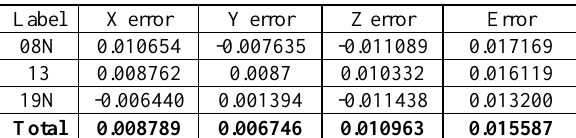
Table 4. Check Point location errors